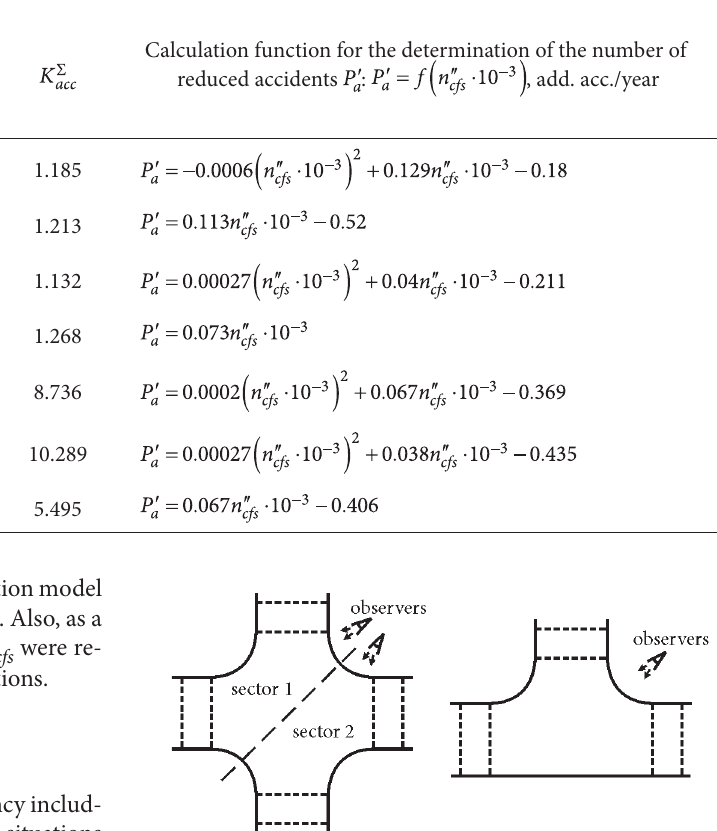
Calculation function for the determination of the number of reduced accidents :